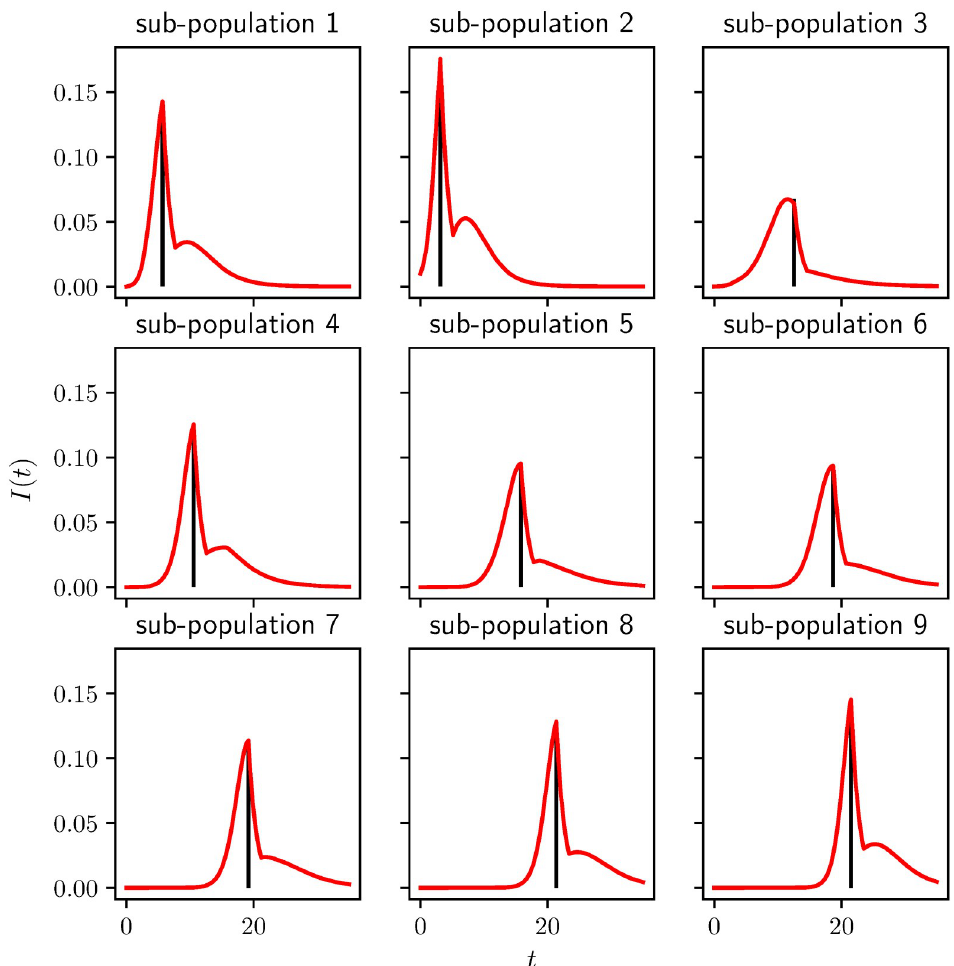
Fig 6. Illustration of best control strategy (i.e. smallest attack rate) (controlling subcommunities individually but using the same threshold for each) when efficacy and duration of control are fixed at c = 0.8 and D = 2, respectively. It turns out that the optimal threshold is close to (0.4). This combination represents the point (0.4, 2) in Fig 5A, or equivalently the point (0.4, 0.8) in D. With this strategy, we find that R ( 1 ) goes from R ( 1 ) = 0.75 to R ( 1 ) = 0.63. If we increase control duration from 2 to 10 we would achieve a further reduction to R ( 1 ) = 0.44. The vertical black lines show the onset of control.